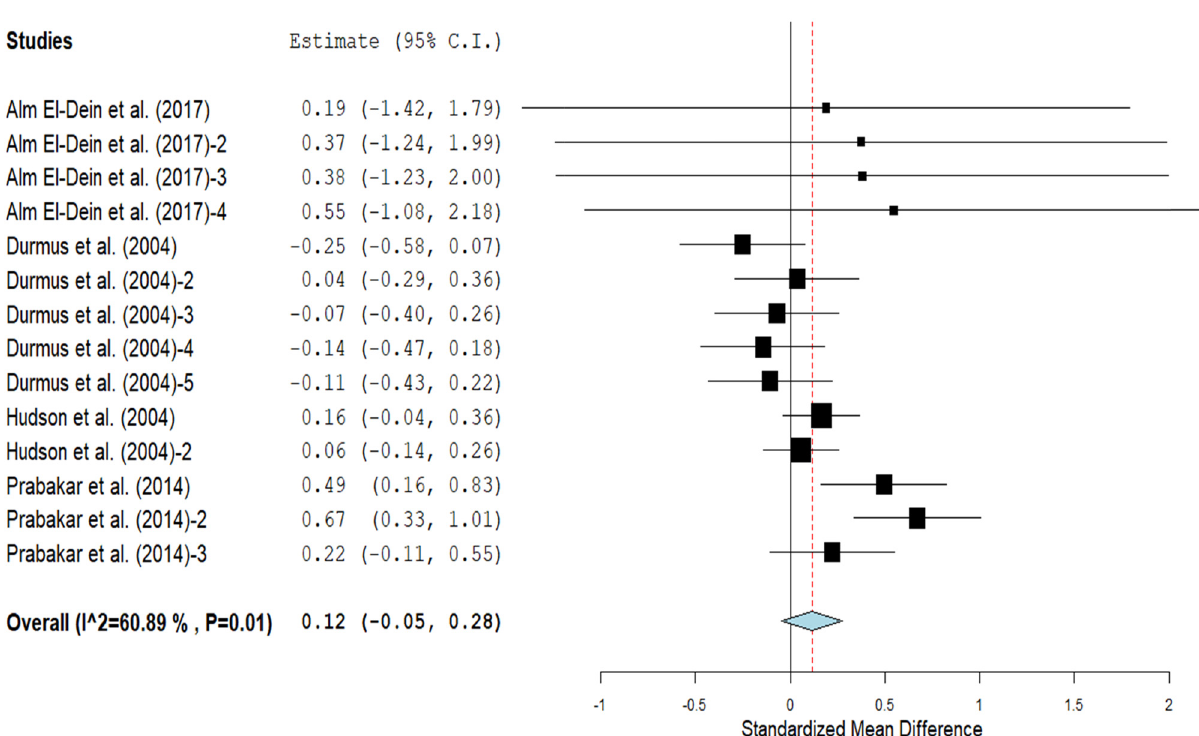
Figure 8: In fl uence of dietary zinc additive on fertility rate in breeder hens. The thick vertical line is the line of no e ff ect ( i.e. SMD = 0 ) . Points to the left of this thick vertical line connote a decrease in fertility rate, whereas points to the right depict an increase in fertility rate in breeder hens. The dotted line shows the overall SMD. The result is considered signi fi cant the 95% CI of the overall SMD did not include